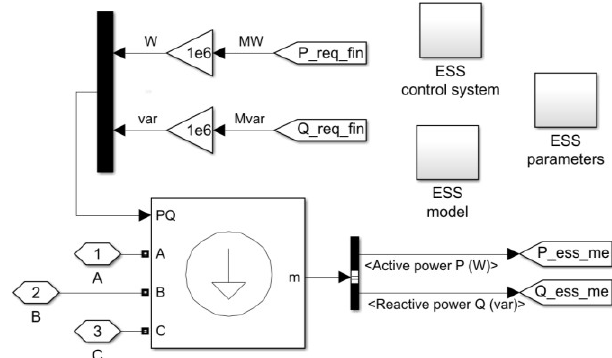
Figure 3. The general structure of the ESS